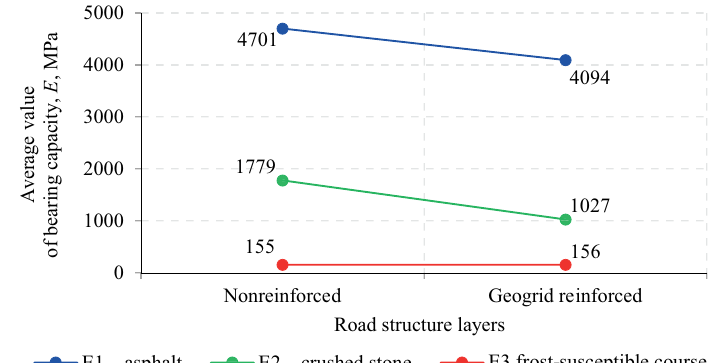
Figure 12. Average values of bearing capacity in the main